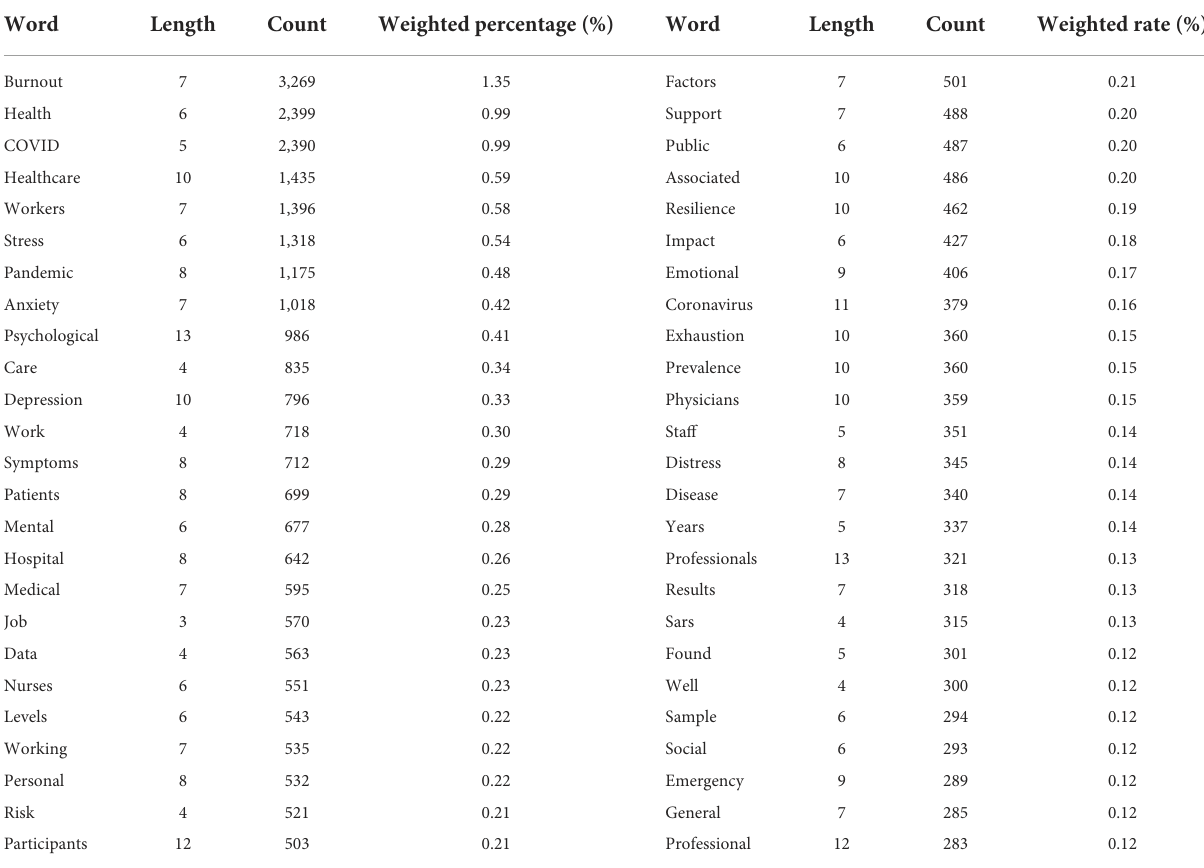
TABLE 5 Trending topic of healthcare workers’